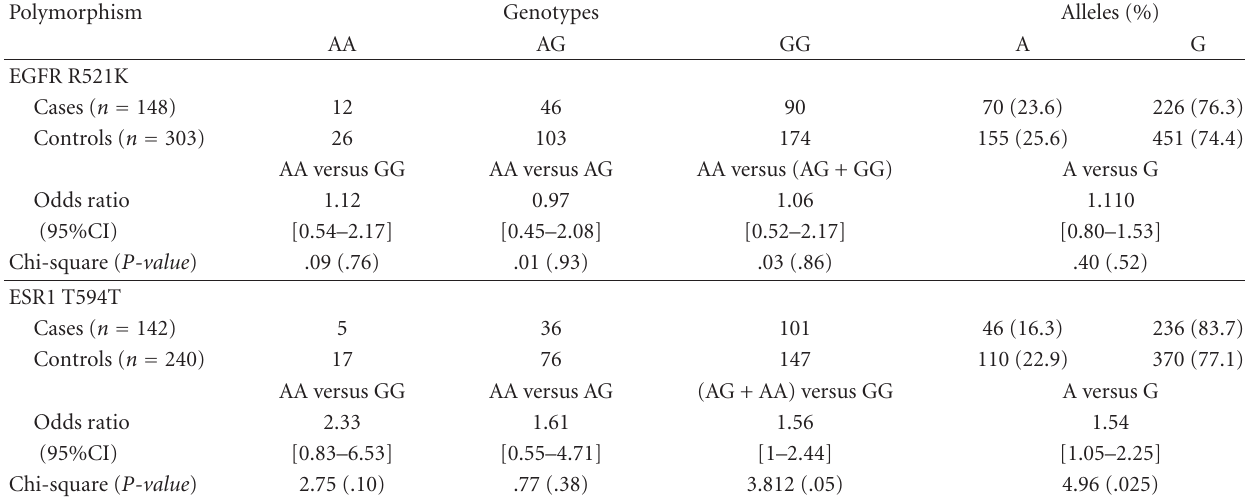
Table 2: Allelic and genotype distribution frequencies of R521K and T594T polymorphism in the patients and the control